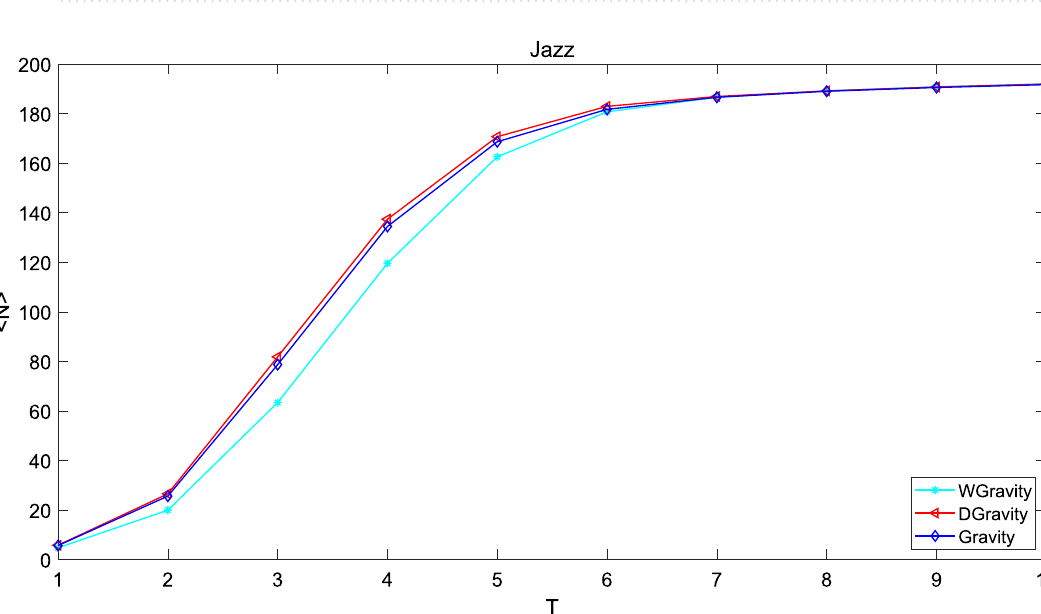
Figure 12. This figure compares the new model with Gravity model and weighted gravity model based on average infected nodes in network Jazz. Number of average infected nodes increases with time and eventually stabilizes. The growth rate decreases with time, and finally approaches to 0. The new model performs slightly better than Gravity model and much better than weighted gravity model. Because the number of average infected nodes of the new model is larger than that of Gravity model and weighted gravity model until it goes steadily which means that the top 50 nodes calculated by the new model are more important in the